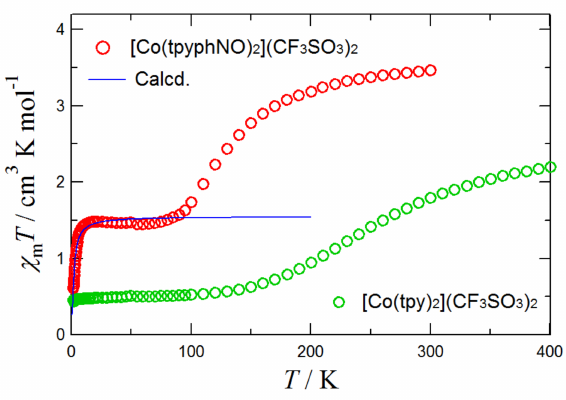
Figure 3. Temperature dependence of χ m T for polycrystalline [Co(L) 2 ](CF 3 SO 3 ) 2 (L = tpyphNO, tpy), measured at 5000 Oe. A solid line represents the calculated curve for a low temperature region. See the text for the equation and optimized